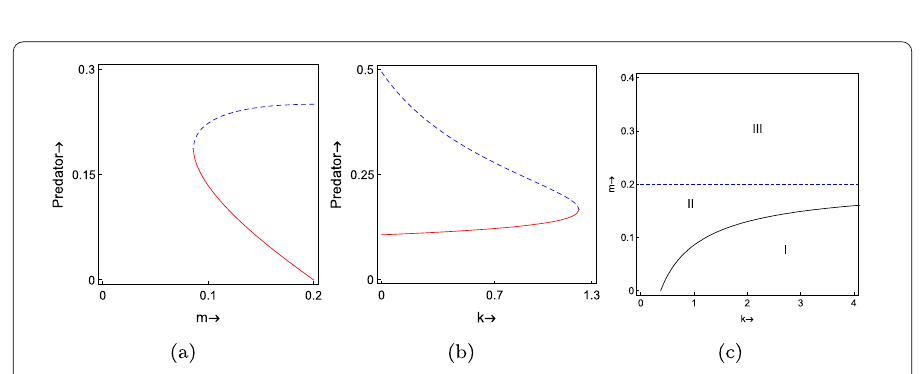
Figure 2 ( a ) Saddle-node bifurcation diagram by fixing k = 1 and m varying in (0, 0.2), the blue dotted line represents stable E 2 and the red line represents unstable E 3 . ( b ) Saddle-node bifurcation diagram by fixing m = 0.1 and k varying in (0, 1.3). ( c ) The black dark curve represents p 2 2 + 4 p 3 1 = 0 which separates Region I (no interior equilibria) and II (two interior equilibria), thed blue dashed line represents m = c which separates Region II and Region III (unique interior